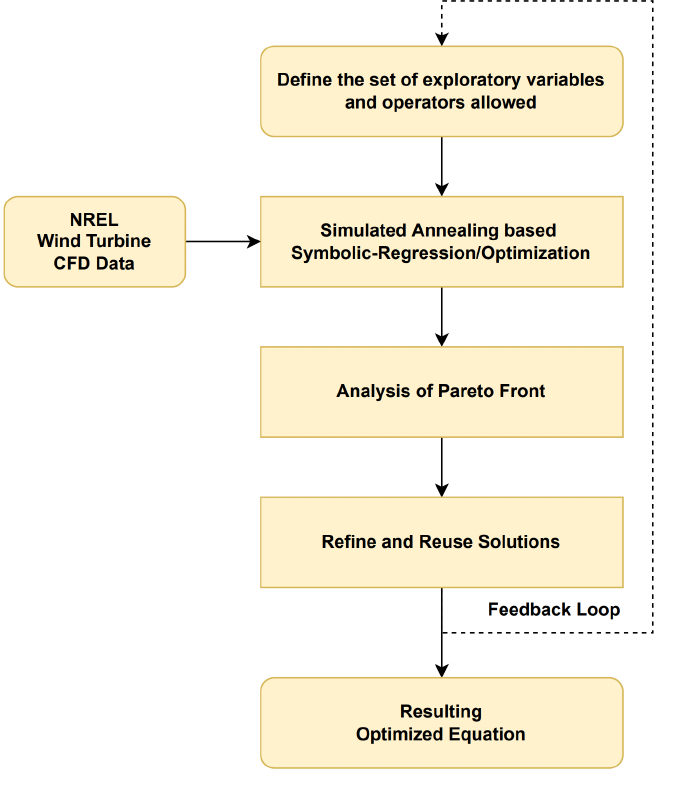
Figure 4. Flowchart of symbolic regression